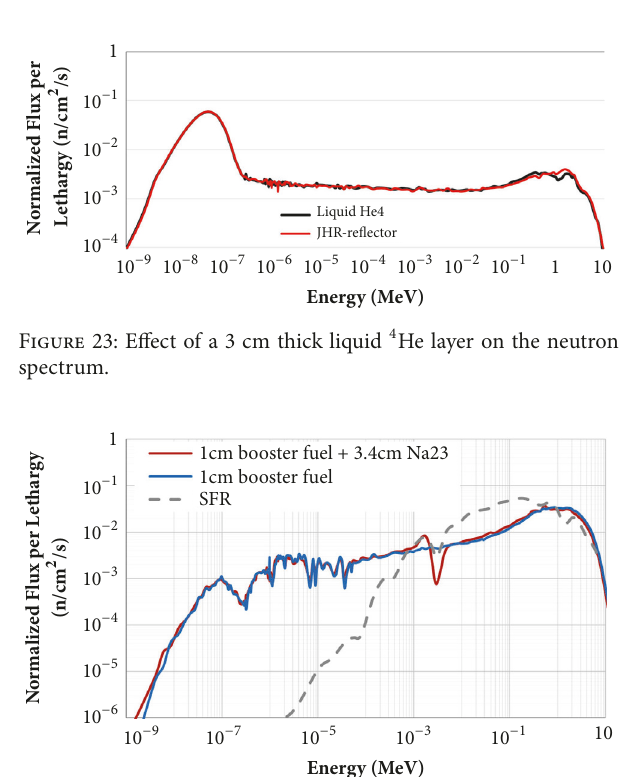
Figure 24: Effect of a 3.4 cm thick 23 Na layer on the neutron